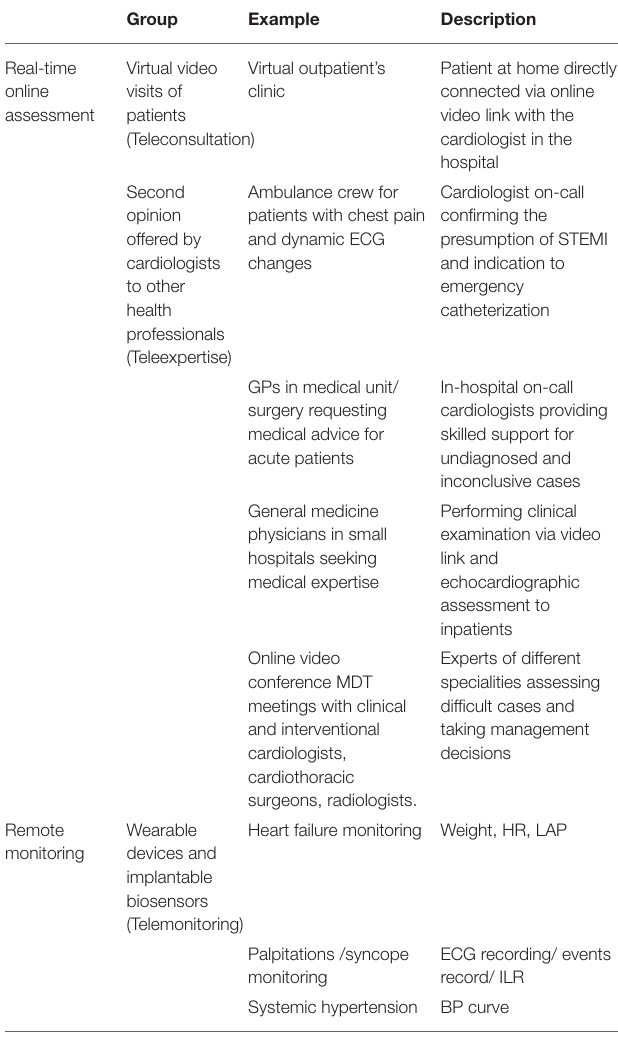
TABLE 1 | Telemedicine groups and description. Group Example Description Real-time